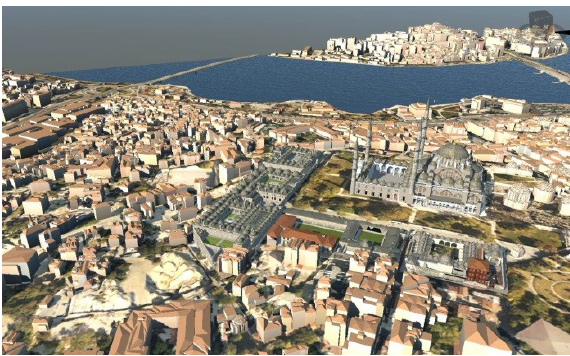
Figure 2: Major landmarks as LoD3